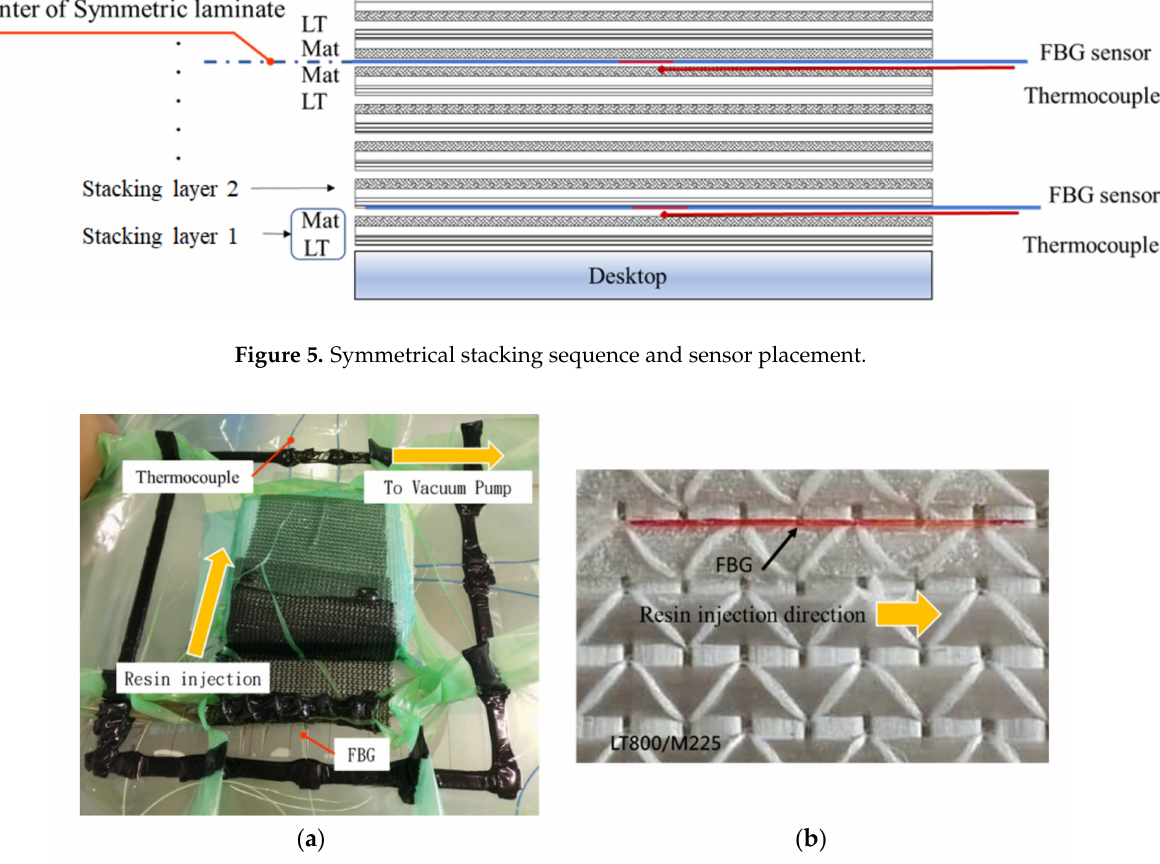
Figure 6. FRP test piece injection and FBG sensor placement. ( a ) VARTM experiment setup. ( b ) Resin injection direction and FBG sensor